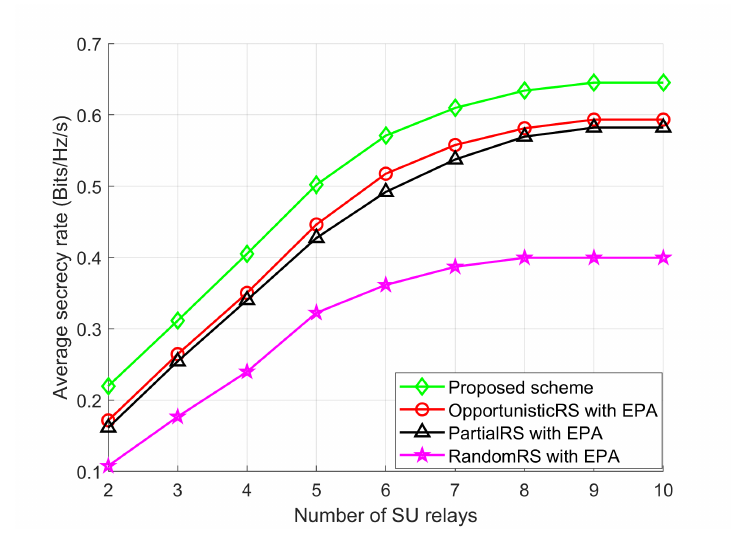
Figure 5. Average SR performance with L .